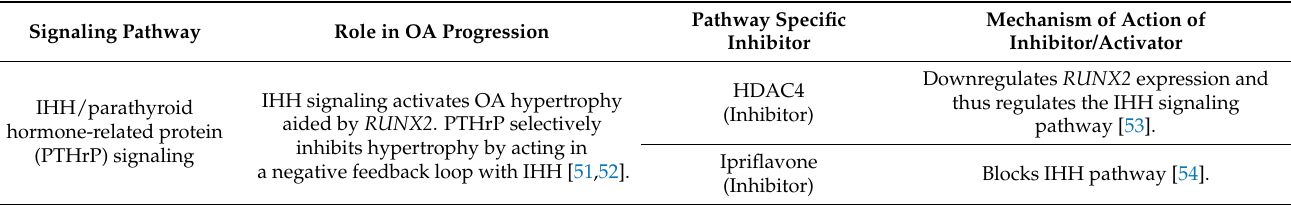
Table 2. Signaling pathways and their modulators involved during hypertrophic OA